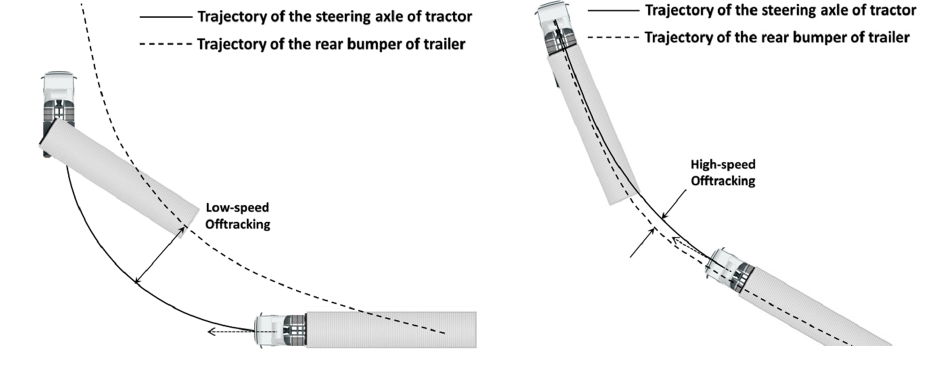
Figure 3. Schematic of off-tracking [15].